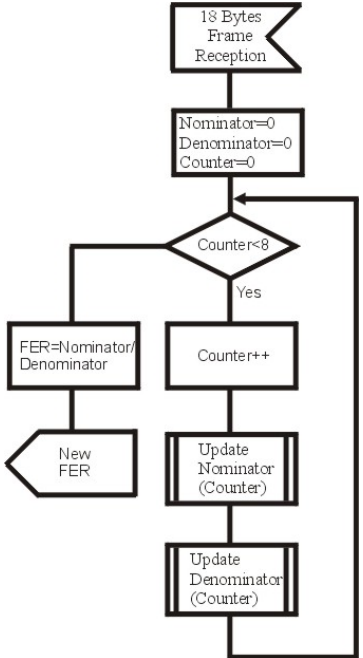
Figure 3. The algorithm for FER